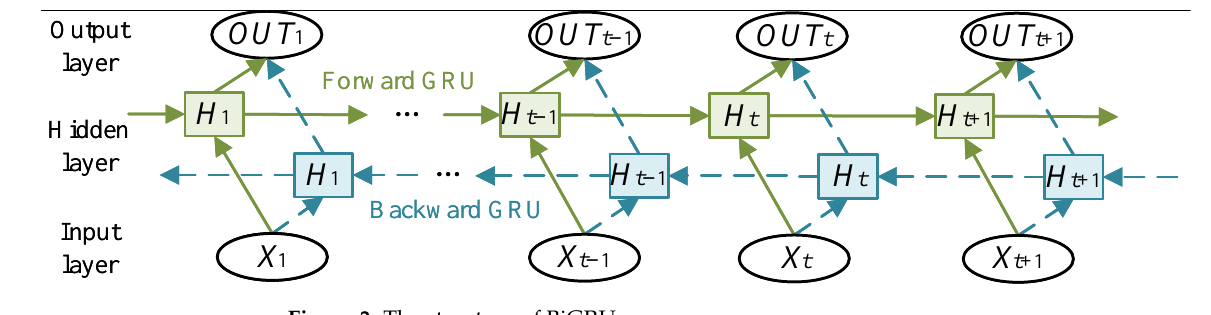
Figure 3. The structure of BiGRU.